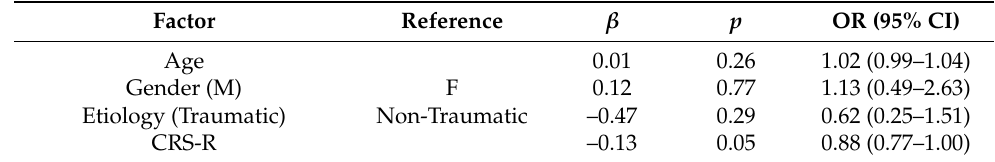
Table 9. Logistic regression model for 137